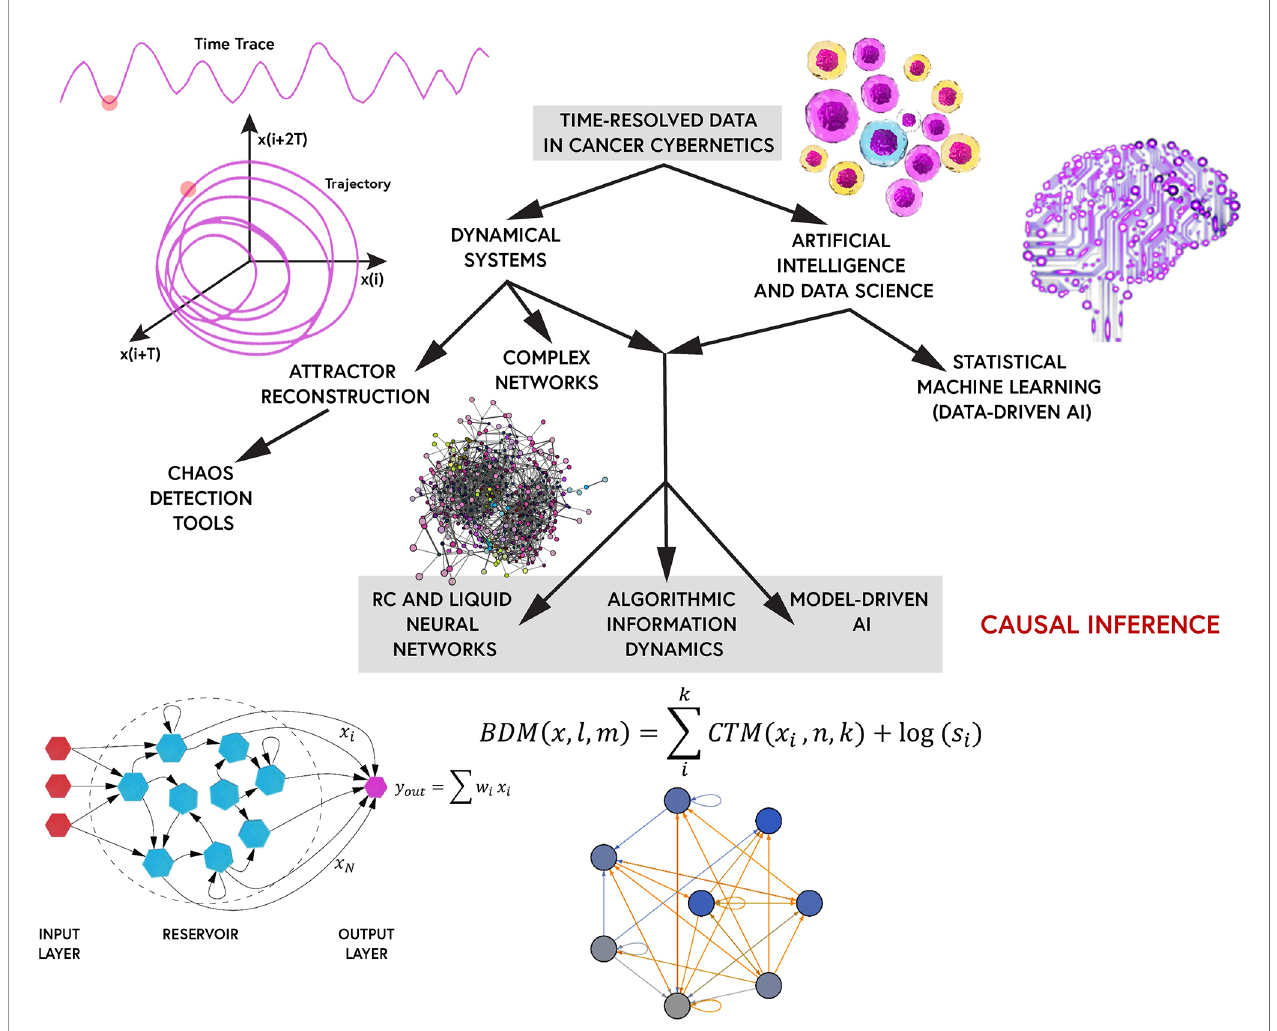
FIGURE 1 | Biological inverse problem. The work fl ow summarizes a blueprint of causal inference methods and measures discussed in the review for systems oncology. Given time-resolved cancer data (e.g., live-cell imaging of protein fl ows, time-sequential transcriptomic pro fi ling, etc.), we can employ complex systems tools such as dynamical systems modelling or statistical machine learning algorithms for pattern discovery. Dynamical systems approaches include attractor embedding followed by chaotic behavior detection tools as discussed, or complex networks inference. Chaotic behavior detection tools comprises of many approaches discussed in the paper including attractor embedding, fractal analysis, frequency spectra, and Lyapunov exponents. However, these approaches may have dimensionality limits and hence, AI- driven causal inference algorithms are proposed as promising tools for causal pattern discovery in single-cell time-sequential analyses, which include algorithmic information dynamics (i.e., measuring the algorithmic complexity of complex graph networks via perturbation analysis in software space), recurrent neural networks (e.g., RC networks, liquid neural networks, etc.), and model-driven AI (e.g., turbulence modelling/multiscale computational fl uid